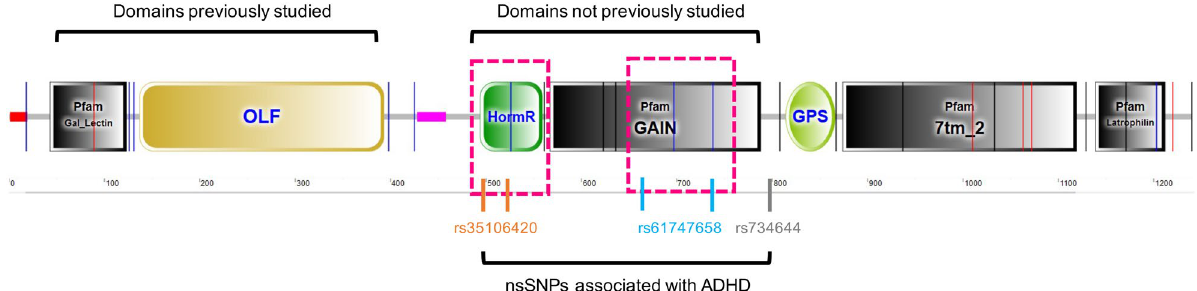
Figure 1. Schematic representation of ADGRL3 and its domains. Squares in pink represent the encoding genome areas of the protein harboring functional nsSNPs as defined by the in-silico analysis. Gal_Lectin: Galactose binding lectin domain (PF02140.18); OLF: Olfactomedin-like domain (PF02191.16); HRM: Hormone receptor domain (PF02793.22); GAIN: GPCR-autoproteolysis inducing domain (PF16489.5); GPS: GPCR proteolysis site motif (PF01825.21); 7tm_2: 7 transmembrane receptors (Secretin family; PF00002.24); Latrophilin: Latrophilin Cytoplasmic C-terminal region (PF02354.16). ADGRL3 nsSNPs studied herein are located within the region of the HRM and GAIN